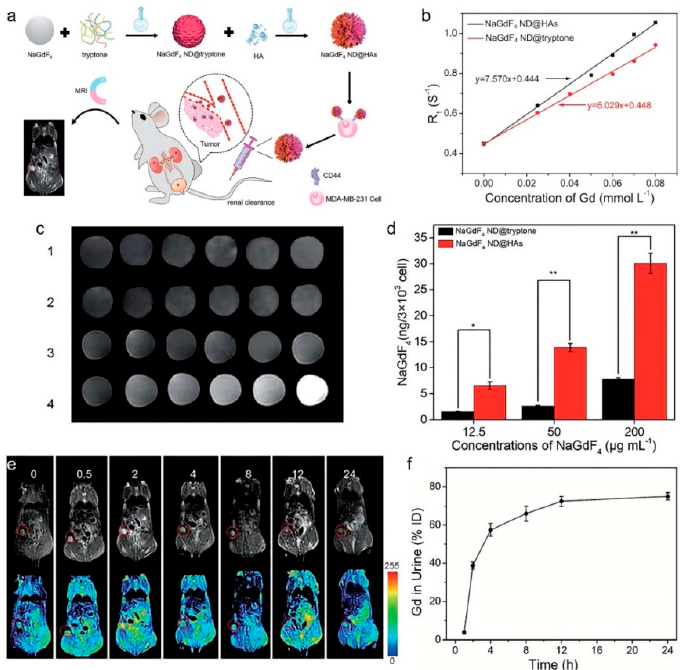
Figure 9. ( a ) Schematic representation of NaGdF 4 ND@HAs synthesis, and the application in MRI of tumor through recognizing the overexpressed CD44 on cancer cell membrane. ( b ) R 1 relaxivities of NaGdF 4 ND@tryptone and NaGdF 4 ND@HAs as a function of the molar concentration of Gd 3+ in solution, respectively. ( c ) MR images of (1) NaGdF 4 ND@HA-stained MCF-7 cells, (2) free HA + MDA-MB-231 cells + NaGdF 4 ND@HAs, (3) NaGdF 4 ND@tryptone-stained MDA-MB-231 cells, (4) NaGdF 4 ND@HA-stained MDAMB-231 cells. ( d ) The amounts of Gd element in the NaGdF 4 ND-stained MDA-MB-231cells. Error bars mean standard deviations ( n = 5, * p < 0.05 or ** p < 0.01 from an analysis of variance with Tukey’s post-test). ( e ) In vivo MR images and corresponding pseudo color images of Balb/c mouse bearing MDA-MB-231 tumor after intravenous injection of NaGdF 4 ND@HAs (10 mg Gd kg − 1 ) at di ff erent timed intervals (0 (pre-injection), 0.5, 2, 4, 8, 12 and 24 h post-injection), respectively. ( f ) The total amounts of NaGdF 4 ND@HAs in mouse urine as a function of post-injection times. Error bars mean standard deviations ( n = 5) (adapted from Yan et al. 2020 [87], Copyright 2020 The Royal Society of Chemistry and reproduced with